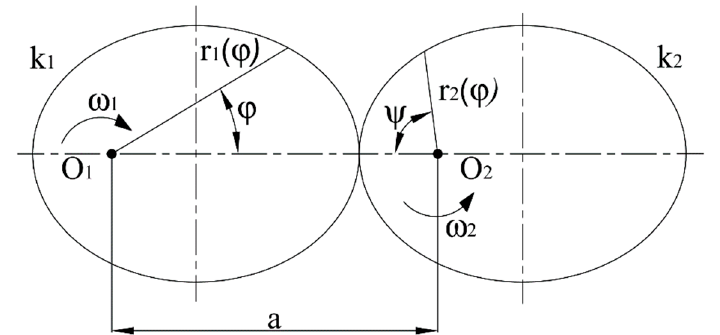
Figure 2. Example of non-circular pitch curves.